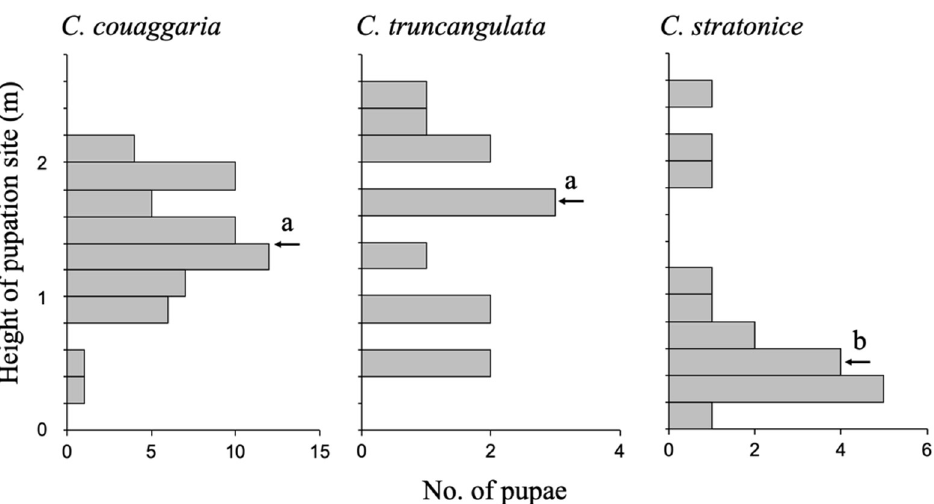
Figure 3. Height of the pupation sites from the ground surface of the three species of Cystidia moths; C. couaggaria ( N = 56), C. truncangulata ( N = 12), and C. stratonice ( N = 17). Arrows indicate medians and the same alphabet denotes insignificant difference ( p > 0.05) in the Steel-Dwass multiple comparison test after the Kruskal–Wallis test ( p < 0.001). Table 1. Pupation sites of the three species of Cystidia moths; C. couaggaria , C. truncangulata , and C. stratonice in the field. The number of pupae found at five categories of pupation sites is shown (see Figure 2).